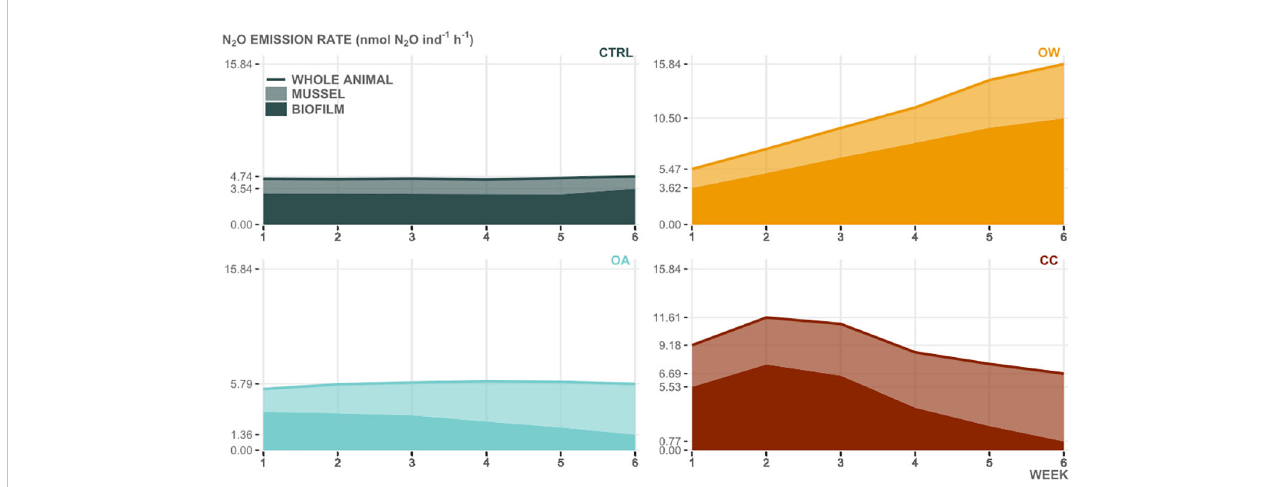
FIGURE 2 Estimated mean relative contribution of dissected Mytilus edulis shells [ SHELL ] to whole animal [ WHOLE ] N 2 O emission rates (nmol N 2 O ind -1 h -1 ) in four experimental treatments [CTRL, control; OA, ocean acidi fi cation; OW, ocean warming and CC: climate change]. Relative contribution of M. edulis itself [ MUSSEL ] represents the calculated difference between the two.